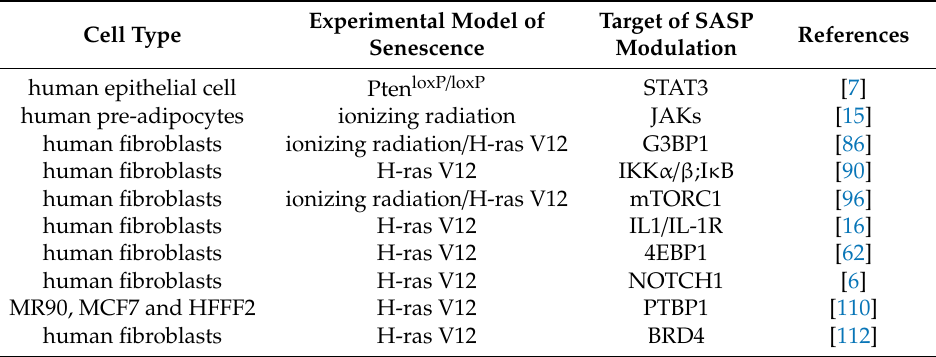
Table 1. Experimental models used to study SASP